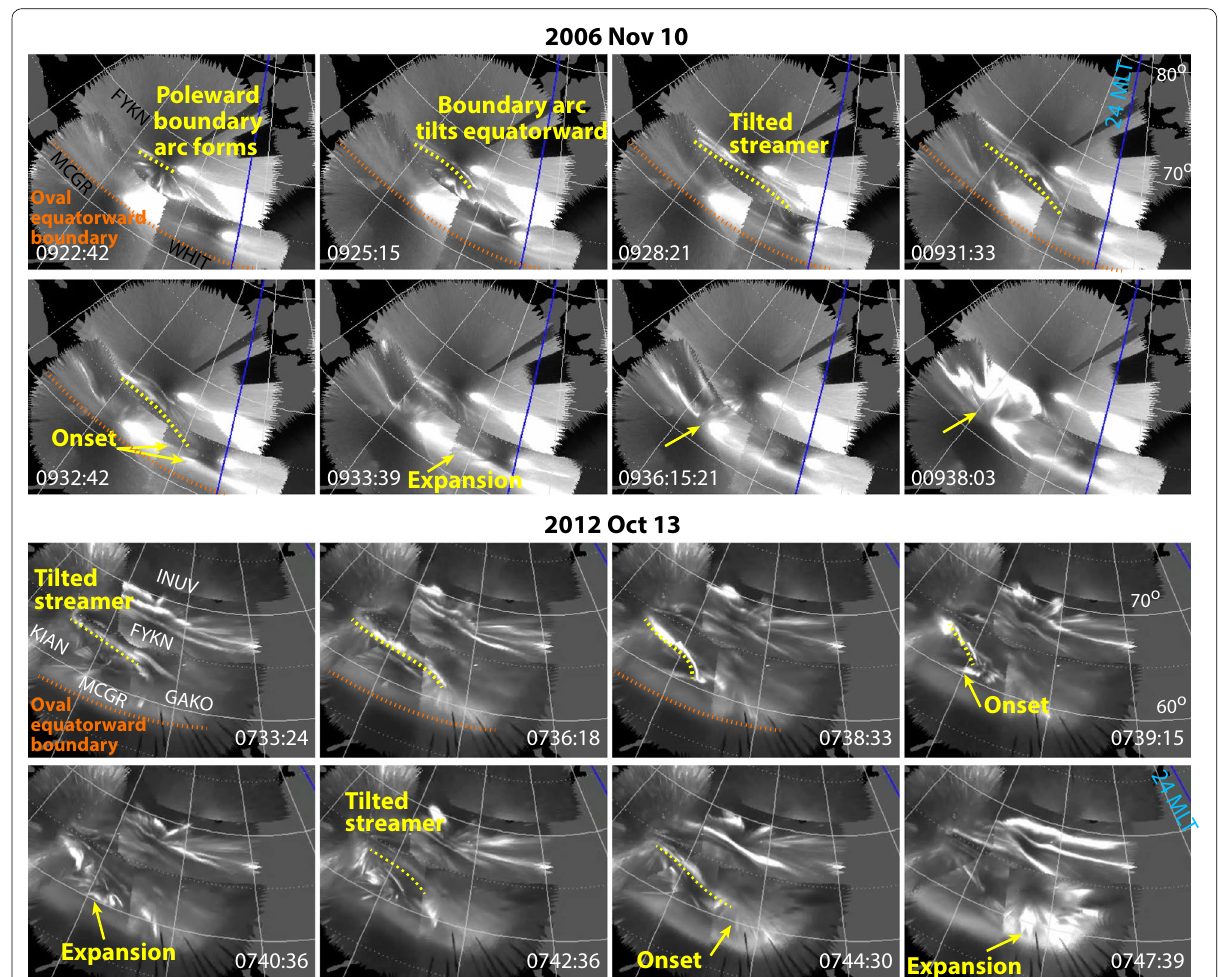
Fig. 3 Examples of events on 10 November 2006 and 13 October 2012 in the same format as Fig. 1 that are consistent with onset triggering by tilted streamers that are not as ideal as the event in Fig.